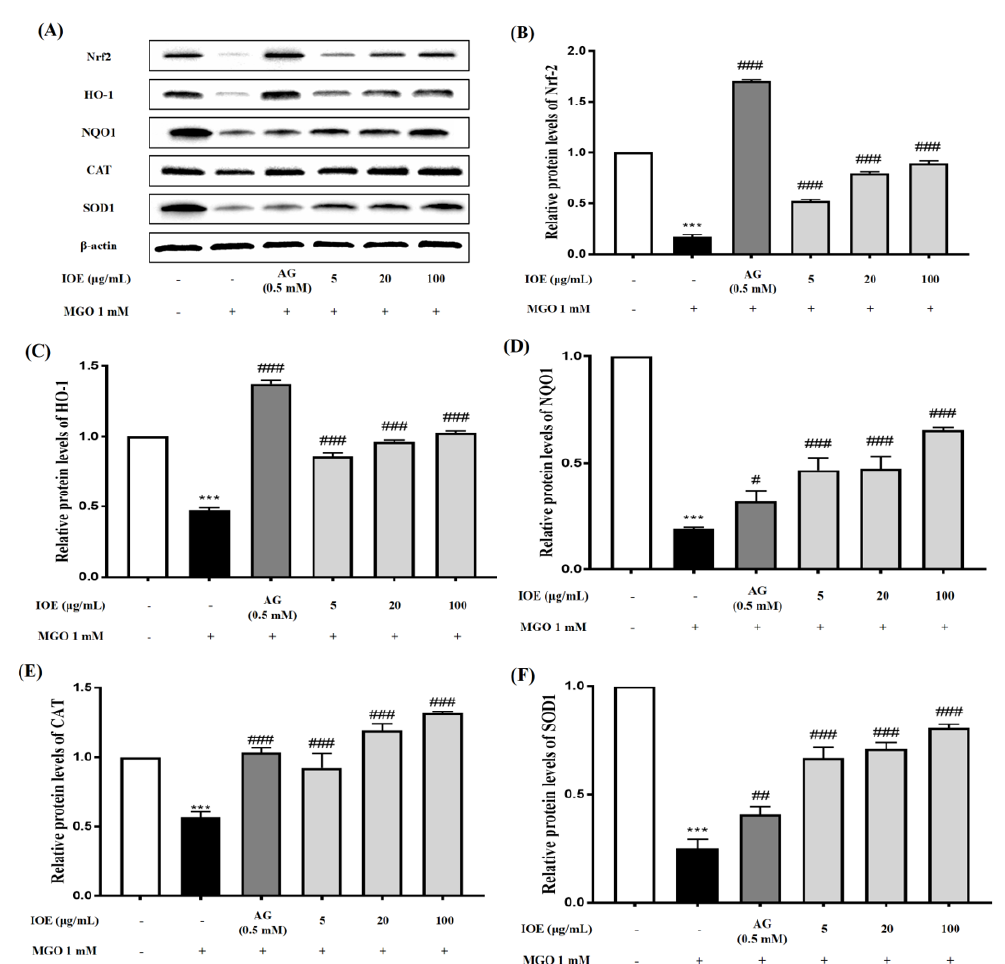
Figure 6. Effect of IOE on expression of Nrf2/ARE in MGO-induced mouse glomerular mesangial cells. Cells were pretreated with IOE for 1 h, followed by incubation with 1 mM MGO for 24 h. The protein expression levels of Nrf2, HO − 1, NQO1, CAT, and SOD1 were measured using Western blot ( A ). Nrf2, HO-1, NQO1, CAT, and SOD1 band intensity; β -actin was used as an internal control ( B – F ). Each experiment was performed three times independently. Bar values are presented as mean ± standard deviation ( n = 3) (*** p < 0.001 vs. normal group and # p < 0.05, ## p < 0.01, and ### p < 0.001 vs. MGO − treated group).